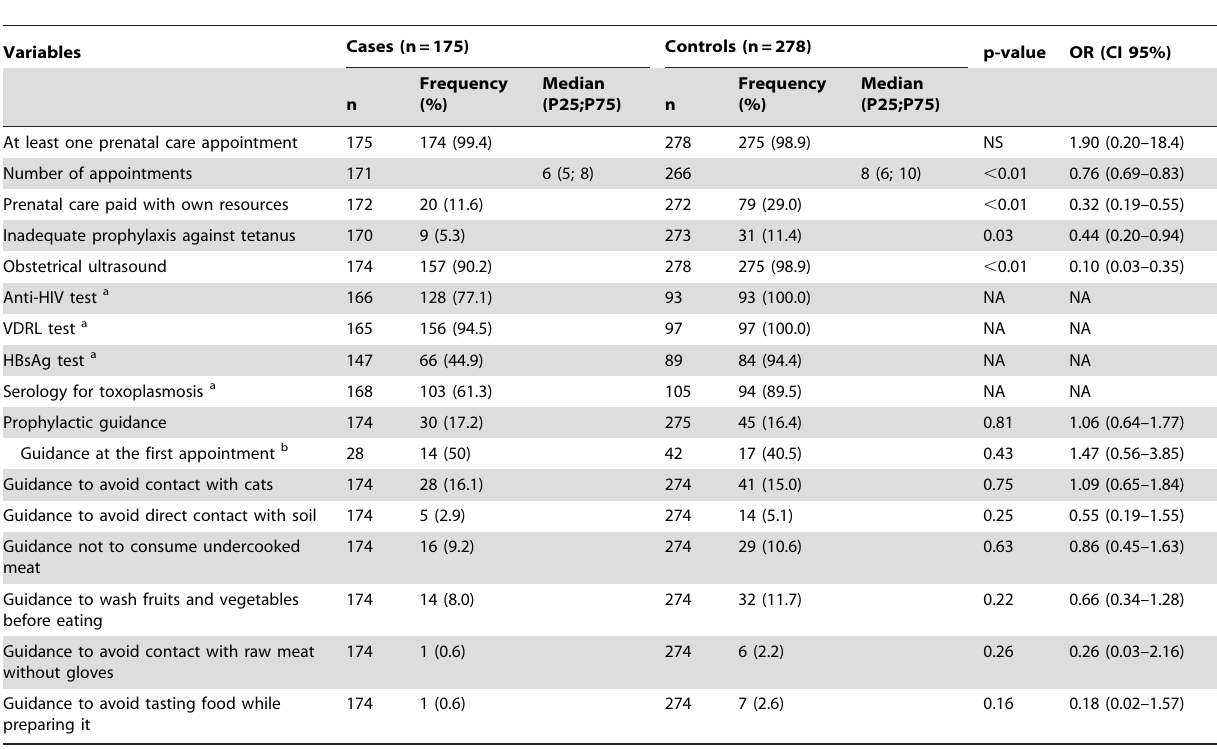
Table 2. Univariate analysis of the characteristics of prenatal care provided to the mothers of children with congenital toxoplasmosis and their controls identified in the scope of the newborn screen program of the State of Minas Gerais.